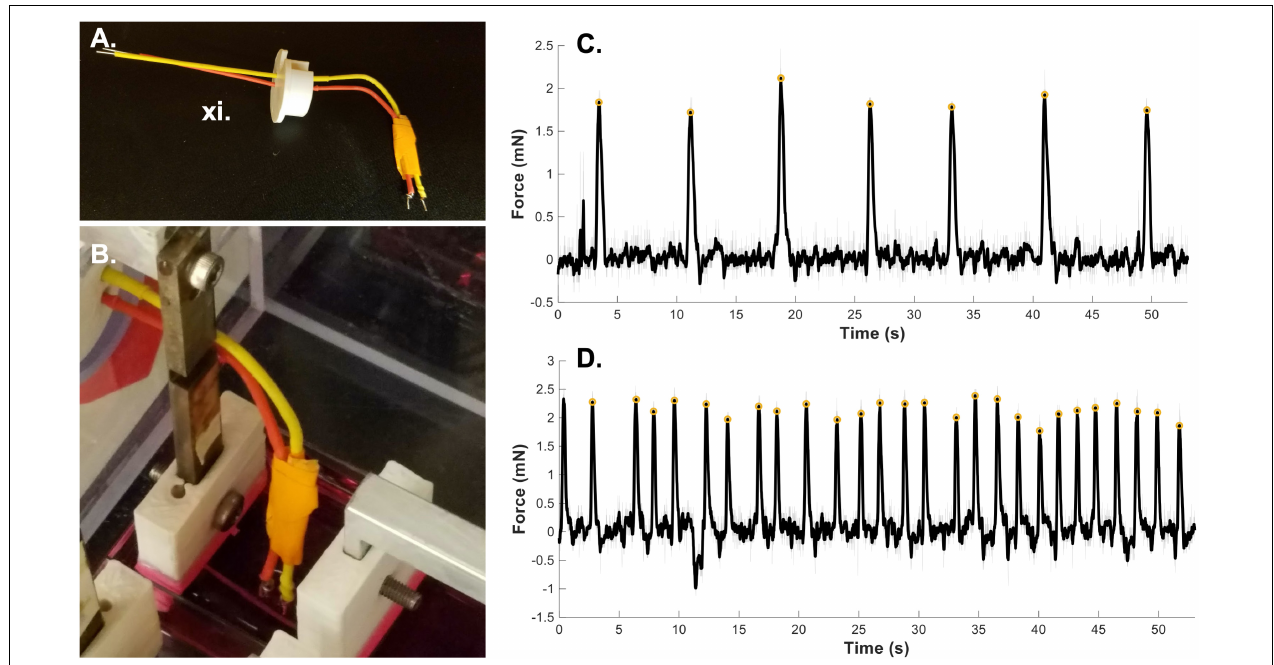
FIGURE 4 | Bioreactor for force of contraction measurement. (A) Stimulated force of contraction is achieved through the use of a point electrode. (B) The electrode is placed in the media bath directly next to the sample. A fibrin microfiber used for skeletal muscle constructs is shown here next to the electrode. (C) A sample graph of spontaneous contractions of a cardiac tissue graft (Morrissette-McAlmon et al., 2020) demonstrates the ability of the bioreactor to measure spontaneous contractions. (D) A sample graph of stimulated force of contraction of a cardiac tissue graft measured by the bioreactor system (Morrissette-McAlmon et al., 2020). Gray lines indicate raw data, black lines indicate smoothed data, and yellow circles indicate measured peak forces. Roman numerals refer to the list of materials at the beginning of Materials and